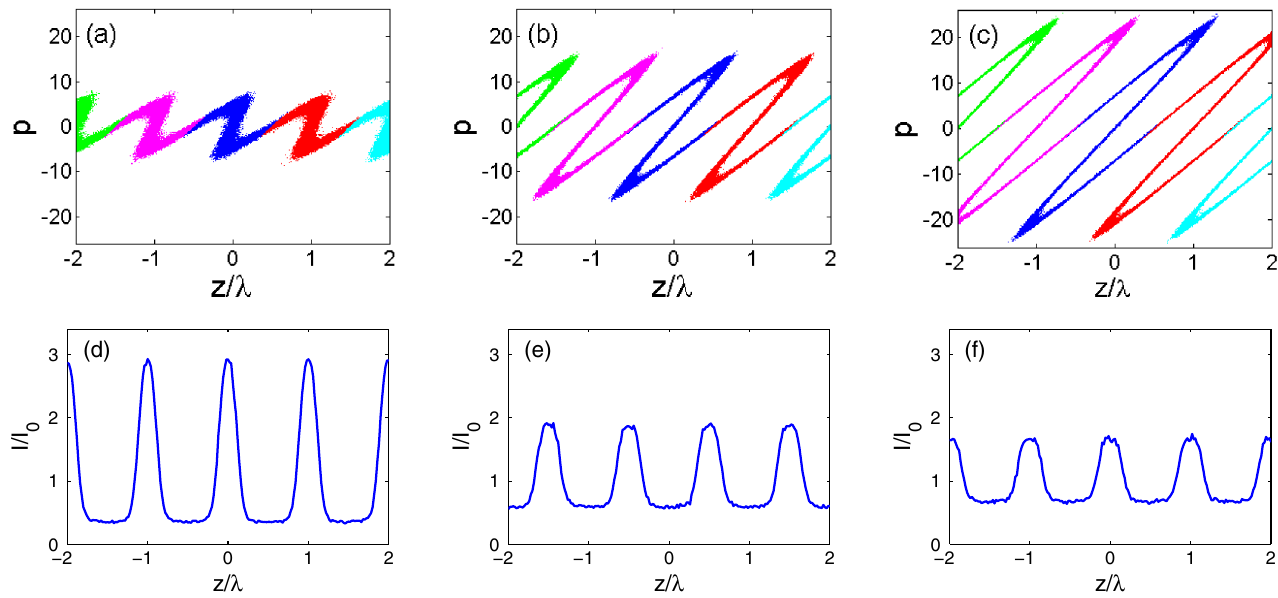
FIG. 2. Longitudinal phase space and current distribution after the chicane when (cid:1) E ¼ 4 : 66keV [(a) and (d)], (cid:1) E ¼ 13 : 49keV [(b) and (e)], and (cid:1) E ¼ 21 : 60keV [(c) and (f)], respectively. Particles initially within the same wavelength are marked with the same